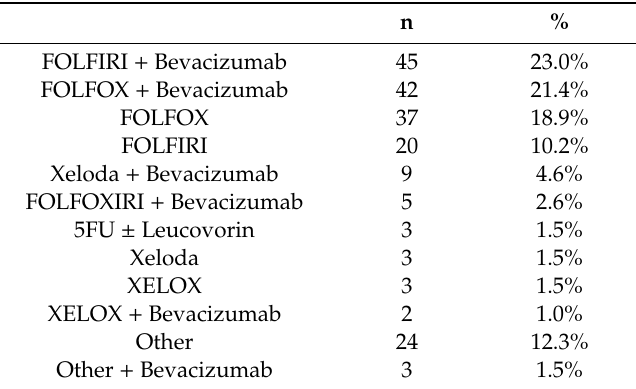
Table 2. Neoadjuvant Chemotherapy Regimens.